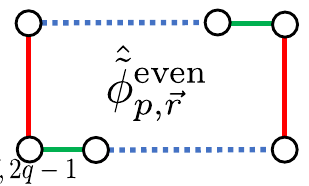
ˆ˜ φ even in Eq. (19) is p , ⃗ r